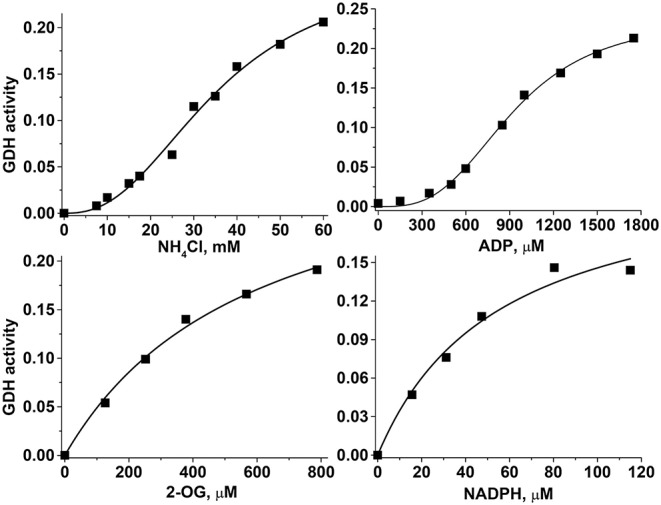
Kinetics of the hepatoma mitochondria reverse GDH reaction. For these representative experiments, 219 μg protein of HepM was incubated in KME buffer at pH 7.20 and 37°C. The saturation curves with variables NH4Cl and ADP were fitted to the Hill equation, whereas the saturation curves with variables 2-OG and NADPH were fitted to the Michaelis–Menten equation. The units of the GDH activity were Δabsorbance at 340 nm min−1.